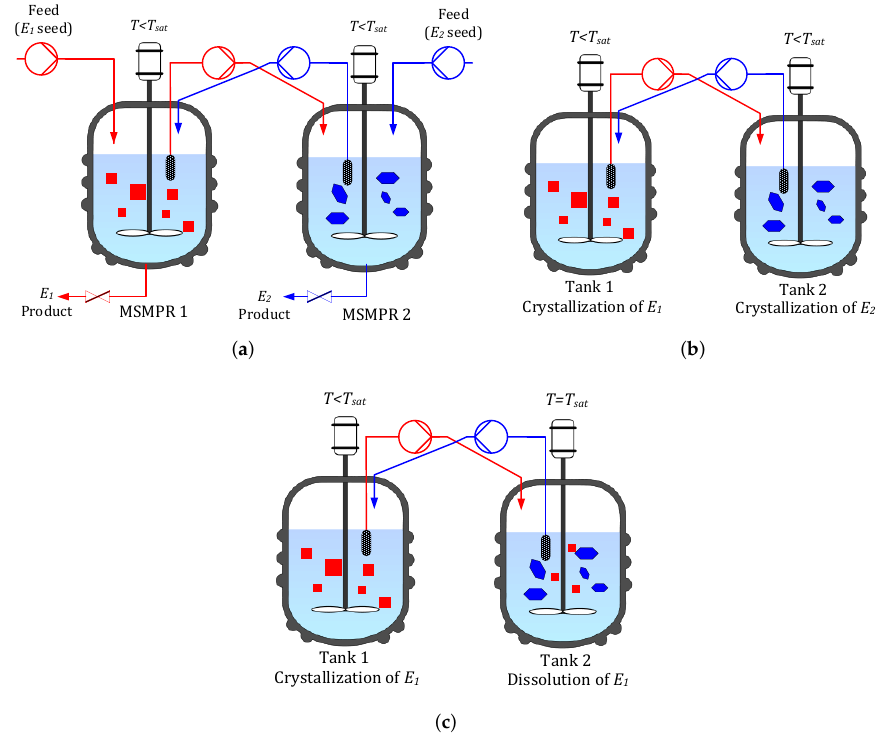
Figure 1. ( a ) Coupled preferential crystallization in MSMPR crystallizers (CPC-MSMPR), where each vessel initially containing supersaturated racemic solution is continuously fed with a slurry containing the seed of the specific enatiomorph. Exchange of liquid phase makes use of the depletion of the counter enantiomer in the other vessel; ( b ) The coupled preferential crystallizer (CPC) configuration, which is similar to CPC-MSMPR except that there is no continuous feed and product removal; ( c ) The coupled preferential crystallization-dissolution (CPC-D) configuration, which is similar to CPC except that Tank 2 (seeded with racemic solid) is maintained at saturation temperature so that dissolution of counter enantiomorph E 1 takes